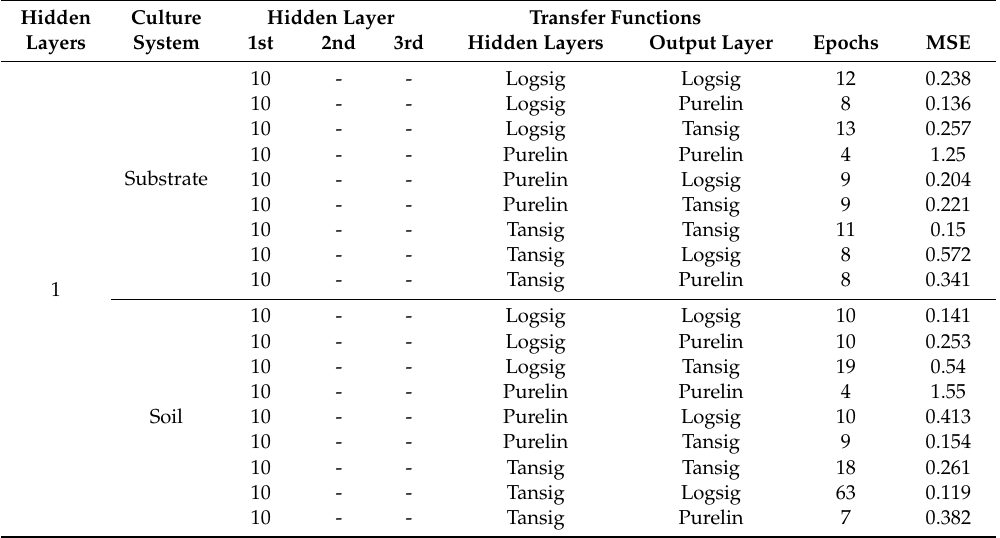
Table 1. Mean square error (MSE) of the evaluated hidden layers topologies for the substrate and soil. Hidden Culture Hidden Layer Transfer